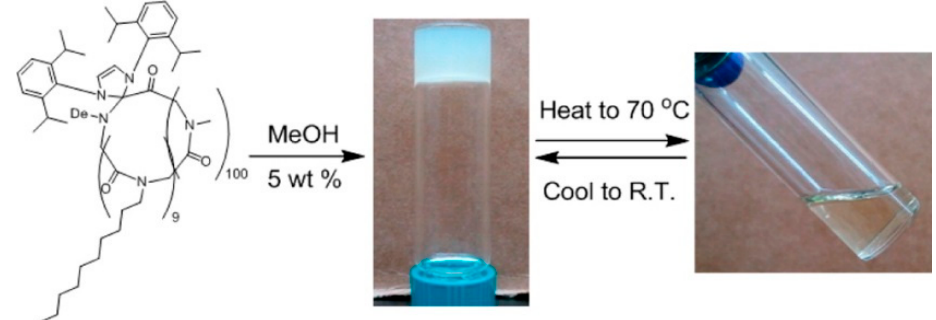
Figure 5. Crystallization-driven thermoreversible gelation of coil-crystalline cyclic and linear diblock copolypeptoids poly( N -methyl-glycine)- block -poly( N -decyl-glycine) Reprinted with permission from [56]. Copyright 2013, American Chemical Society.